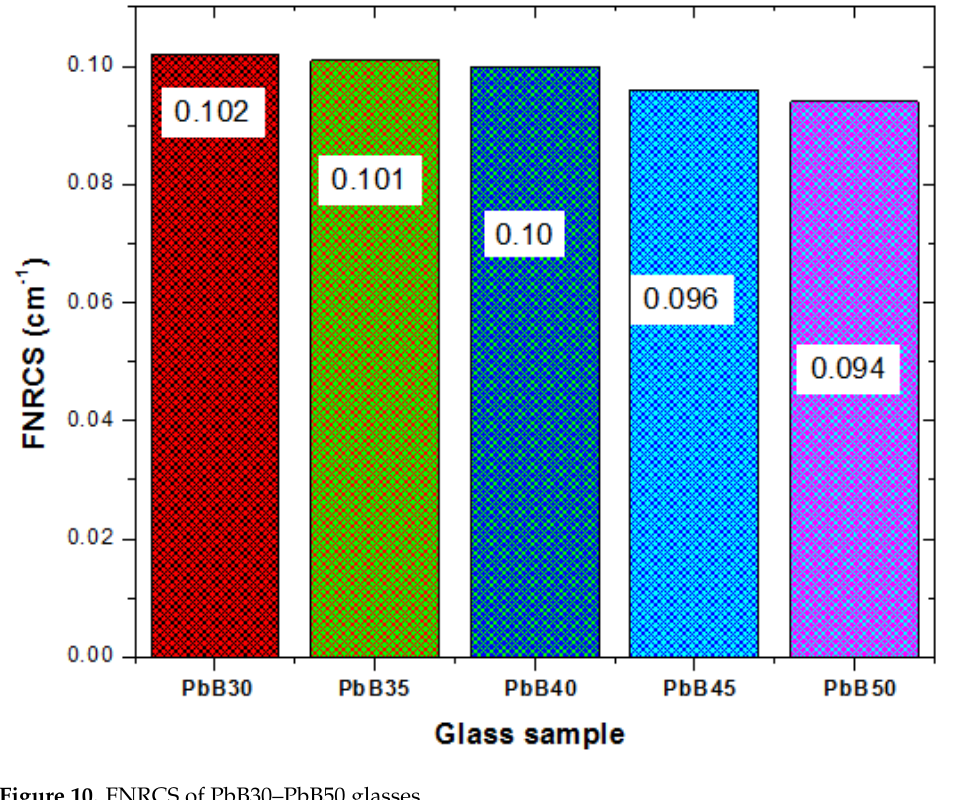
Figure 10. FNRCS of PbB30–PbB50 glasses.